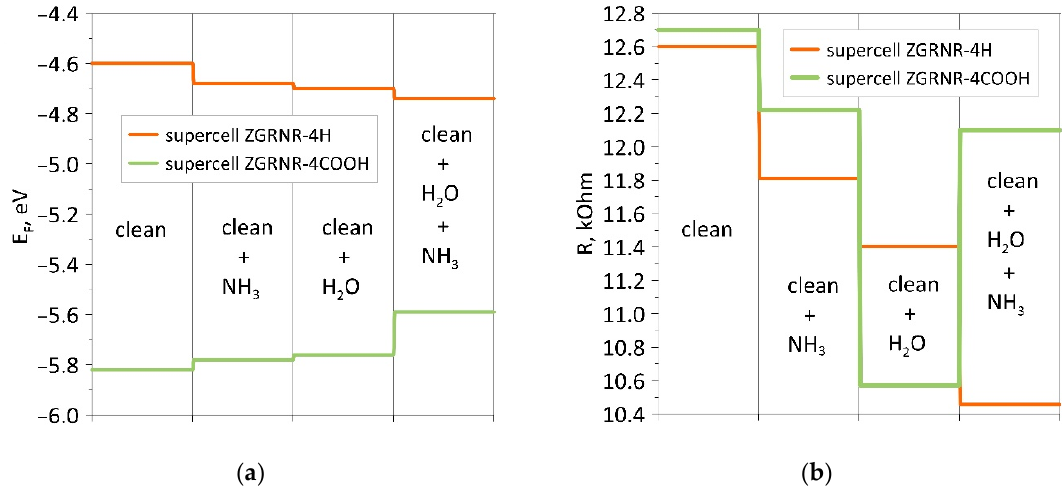
Figure 6. Diagrams of changes in the presence/absence of a COOH group at the edges of the zigzag nanoribbon: ( a ) for the Fermi level; ( b ) for resistance.